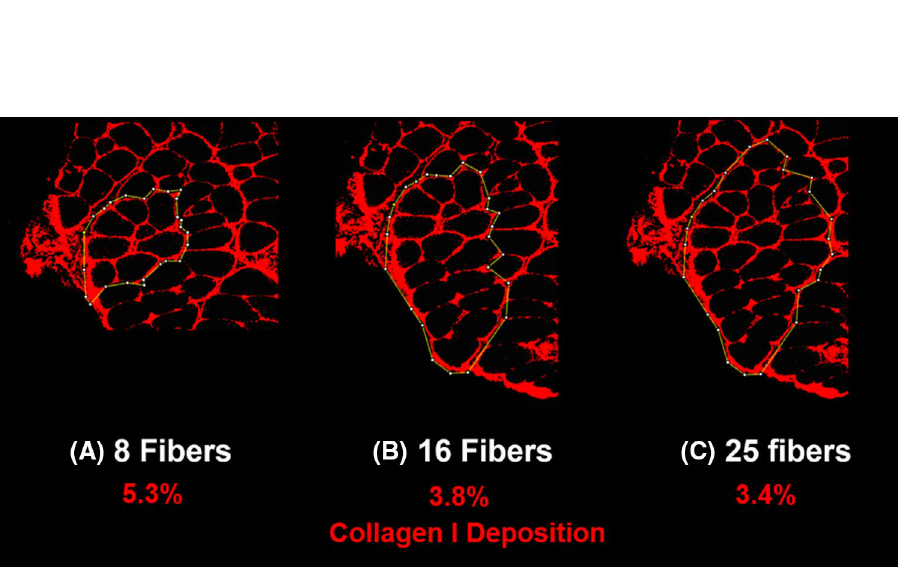
Figure 6. Inverse correlation between collagen I deposition and size of three bundles of different sizes from multifidus of one rat in G1. The measured percentage of collagen I deposition for bundles A, B, and C were 5.3%, 3.8%, and 3.4%,